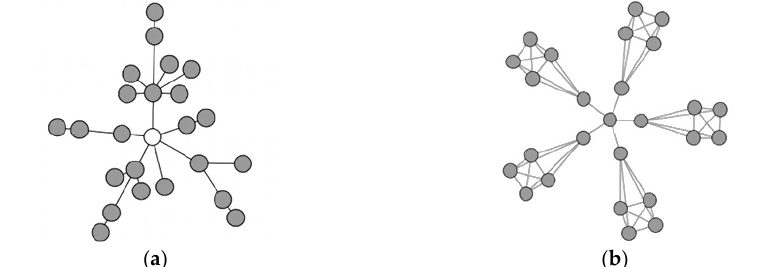
Figure 3. Community visual identification. Source: Reproduced with permission from Matta et al. [3], Applied Sciences; published by MDPI, 2018.